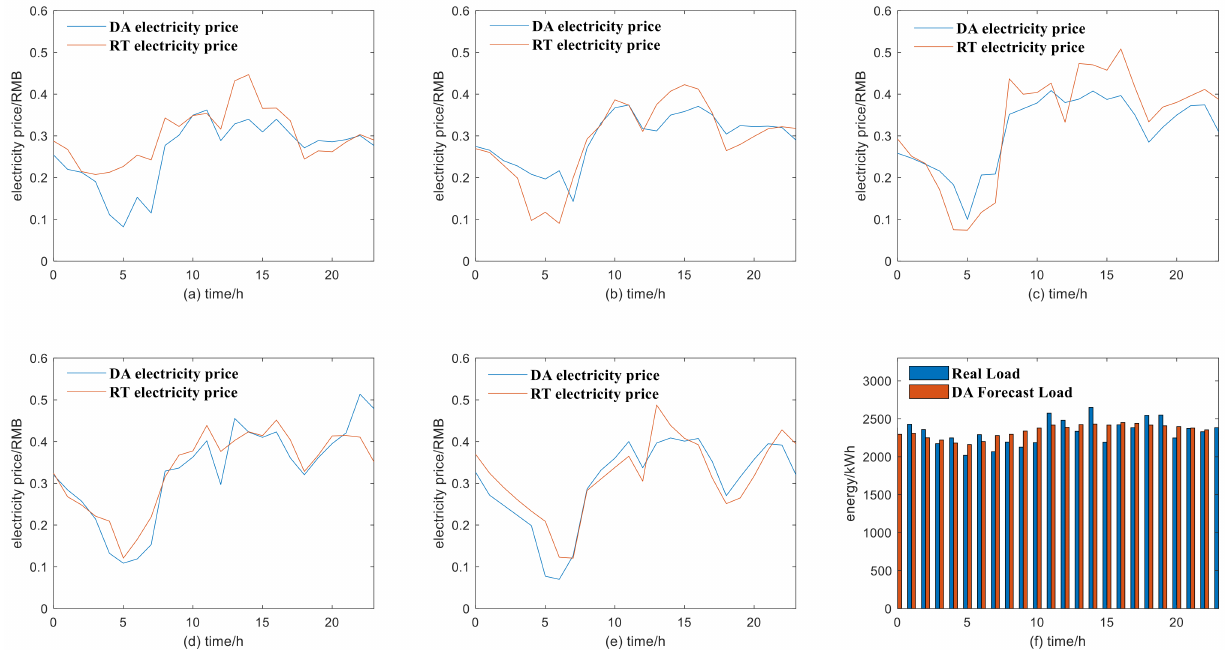
Figure 6. Electricity price curve and typical load curve in Guangdong electricity spot market. Figure reference: Figure ( a – e ): Network public data of electricity price; refer to Appendix A Tables A1 and A2. Figure ( f ): Network public data of typical load curve of load consumer in Guangdong; refer to Appendix A Table A3.